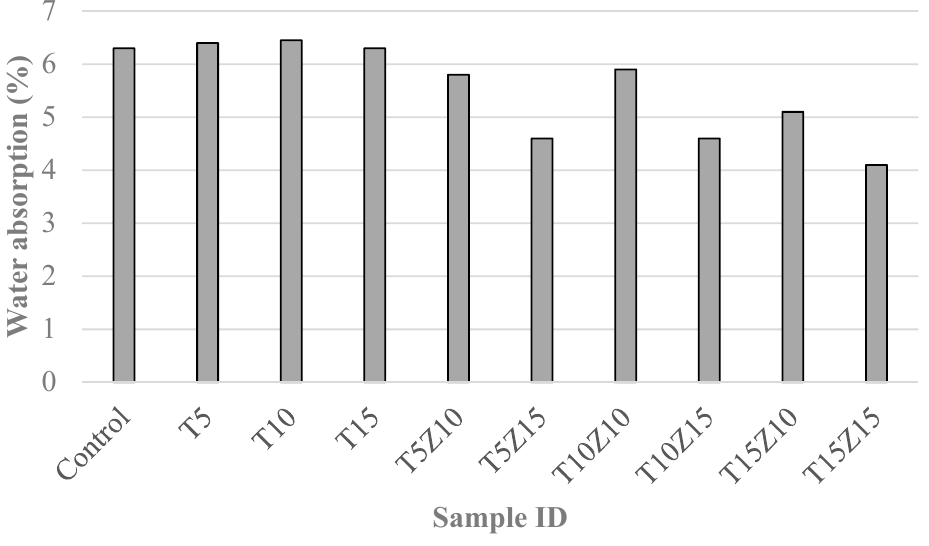
Figure 3. Water absorption of the specimens containing different percentages of zeolite and tuff.